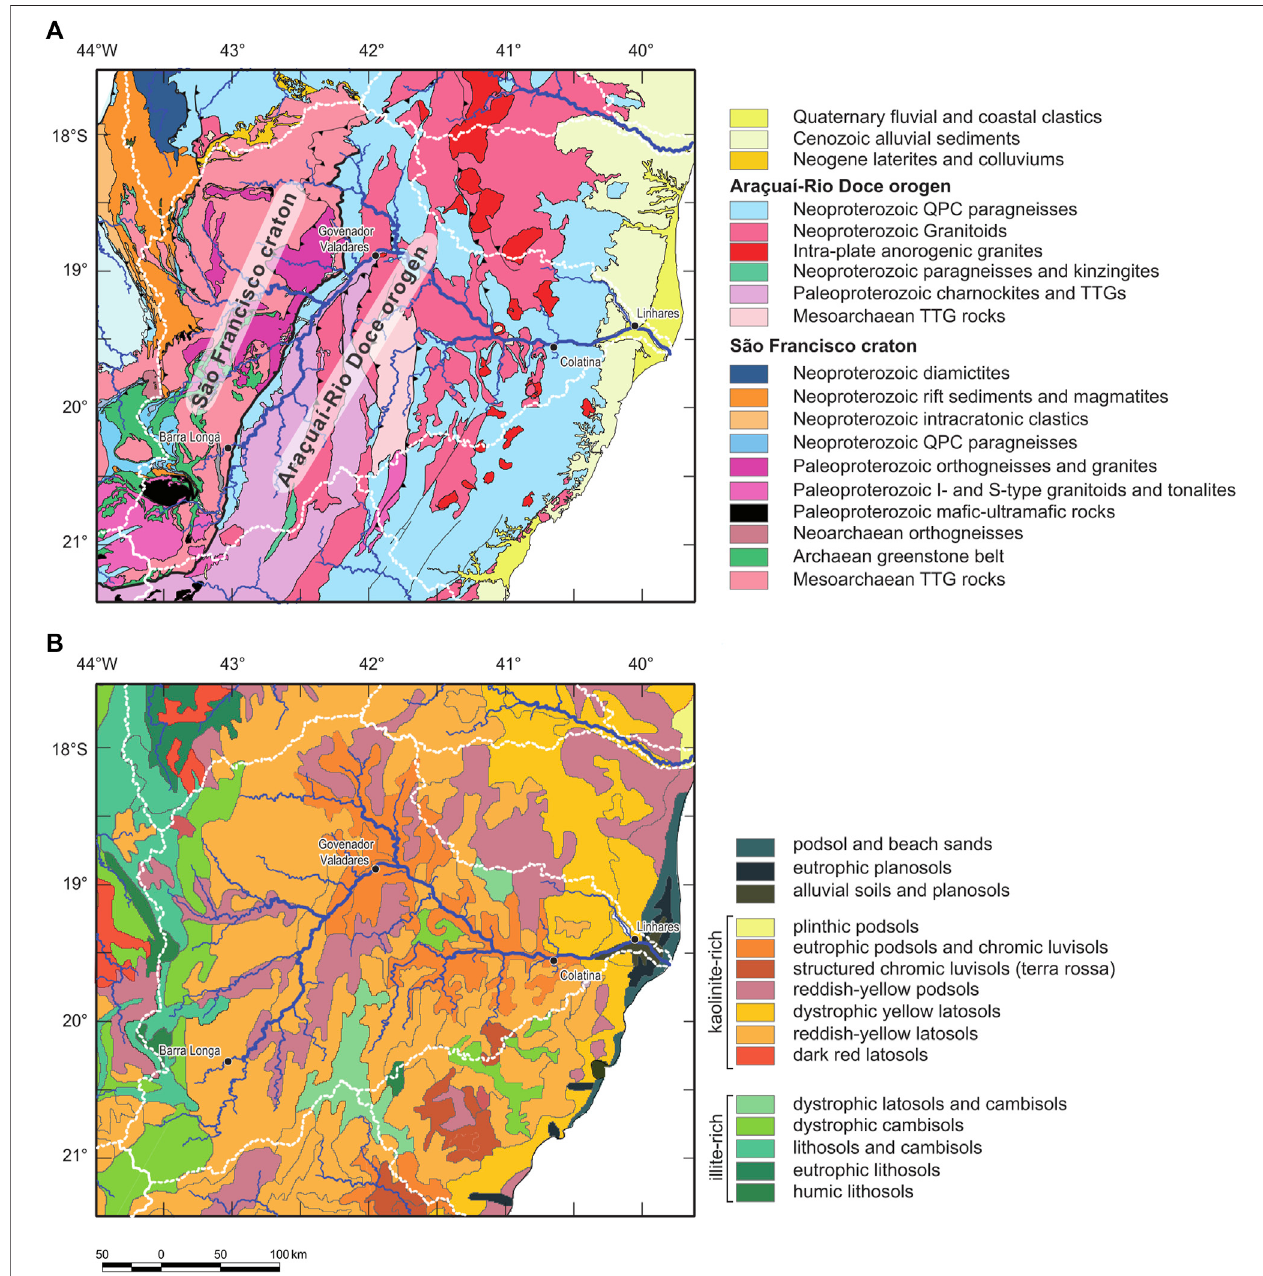
FIGURE 2 | Geologic (A) andsoil (B) mapoftheDoceriverdischargearea.Whitestippledlinesmarktheboundariesofdischargeareas.Geology iscompiledfromthe tectonicmapinsetofthegeologicalmapofBrazil,1:1.000.000,sheetsBeloHorizonte,RioDoce,RiodeJaneiroandVitoria(CPRM – ServiçoGeológicodoBrasil,2004).Soil data are digital versions of the Mapa de Solos do Brasil 1:5.000.000 (Embrapa-SNLCS, 1981; Bliss, 2013), and drainage and discharge data are from GRDC (2020).